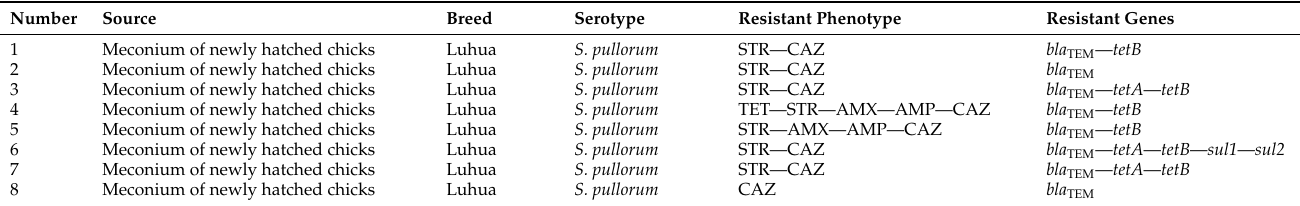
Table 3. Characterization of ESBL-producing isolates.